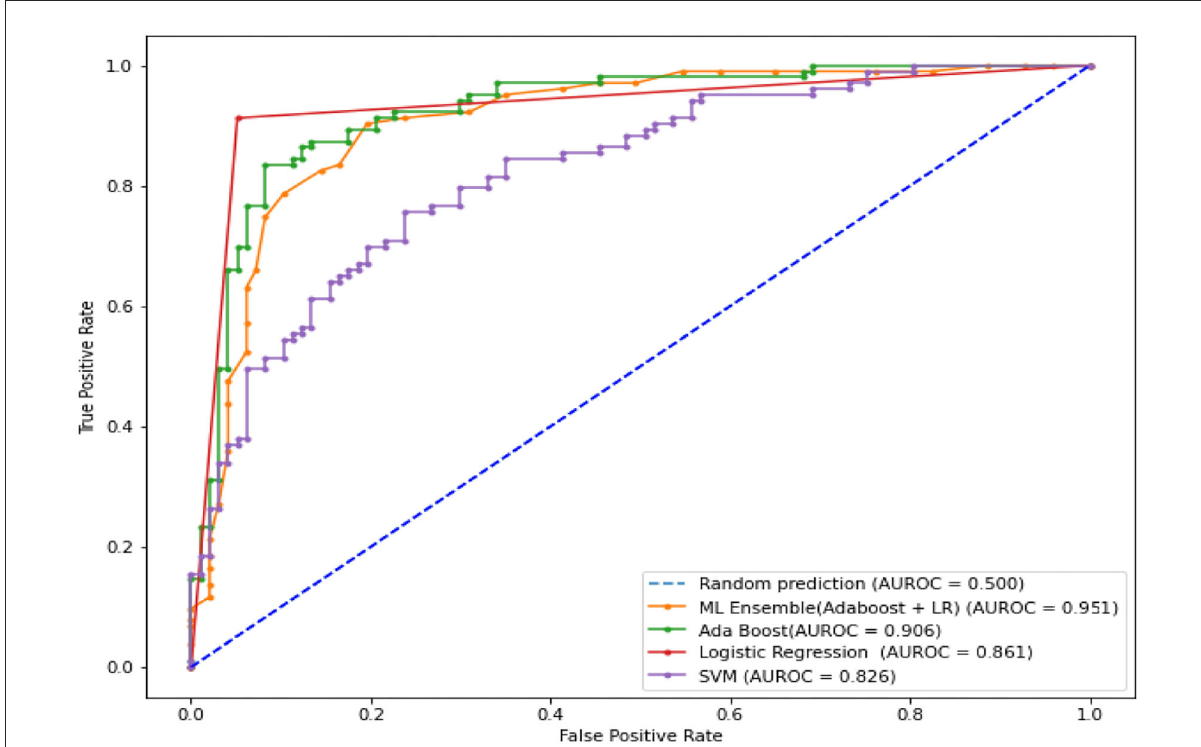
FIGURE6 Comparison of ROC plots and AUC values of LR, AdaBoost, SVM, and LR-AdaBoost ensemble models (PTB-ECG dataset).